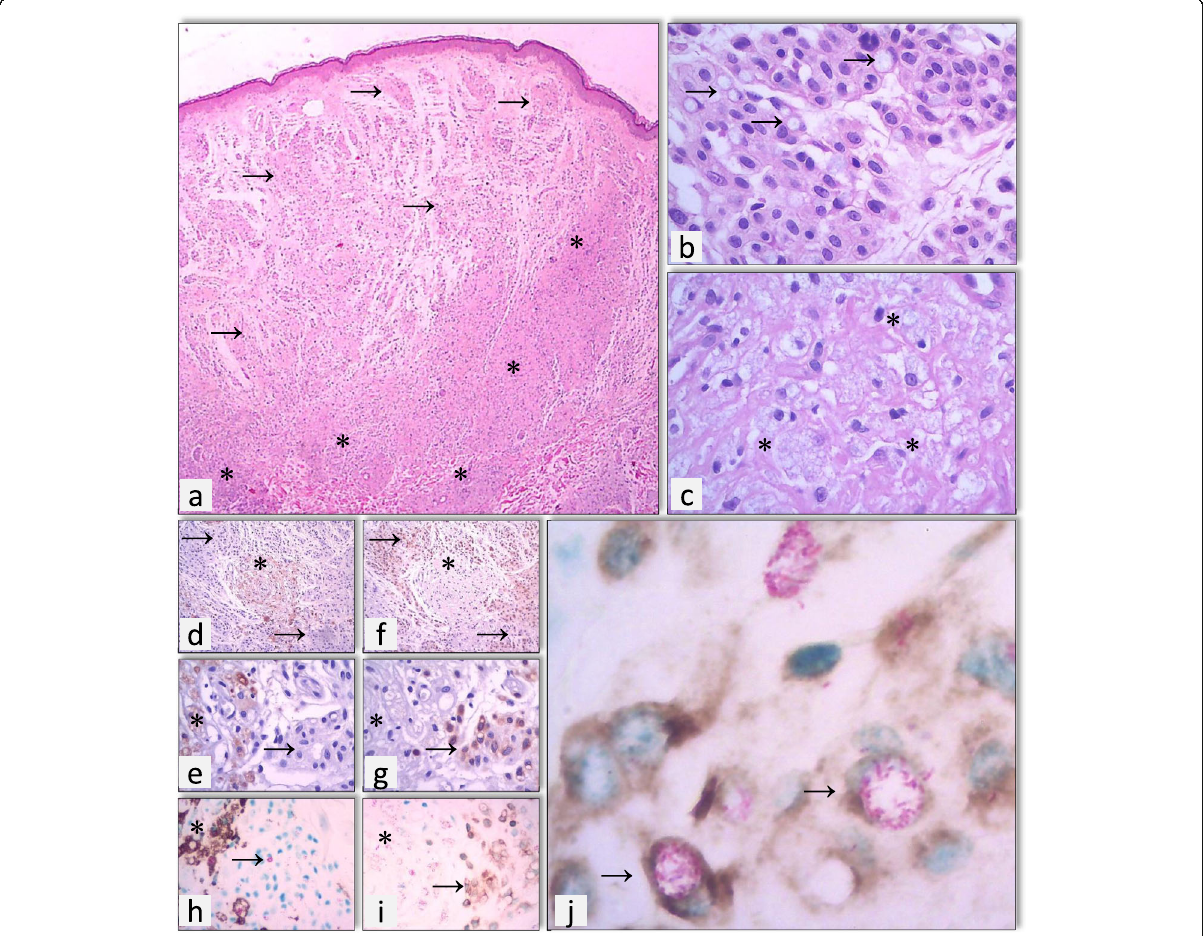
Fig. 2 Parasitism of melanocytic nevus by M. leprae in case 2. a Histological sections showing intradermal melanocytic nevus ( → ) and leprosy lesion (*) (HE). b Melanocytic nevus cells characteristically have intracytoplasmic vacuoles that are filled by M. leprae ( → ) (HE). c Leprosy lesion adjacent to nevus cells with LL characteristics (*). d and e Immunohistochemistry (IHC) showing CD68-positive macrophages (*) and adjacent negative nevus cells ( → ). f and g IHC showing melanocyte-positive cells for Melan A ( → ) and negative macrophages in adjacent tissues (*). h Double staining (IHC-CD68 and FF) showing leprosy lesion macrophages immunostained (*) and non-immunostained nevus cells ( → ) containing bacilli in the cytoplasm. i Double staining (IHC-Melan A and FF) showing non-immunostained leprosy lesion (*) and immunostained nevus cells ( → ), both containing bacilli